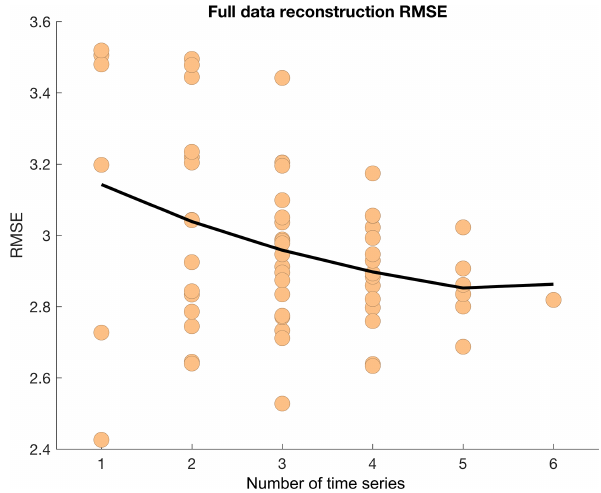
Figure 10. Full data reconstruction RMSE using different numbers of time series as input for